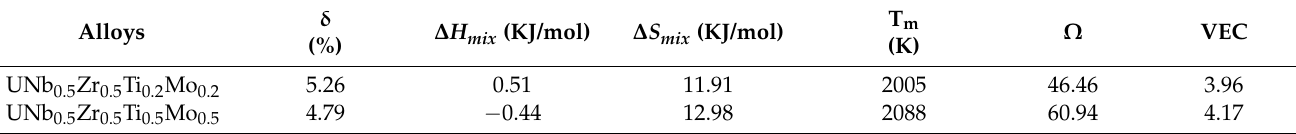
Table 8. Thermodynamic parameters of U-Nb-Zr-Ti-Mo